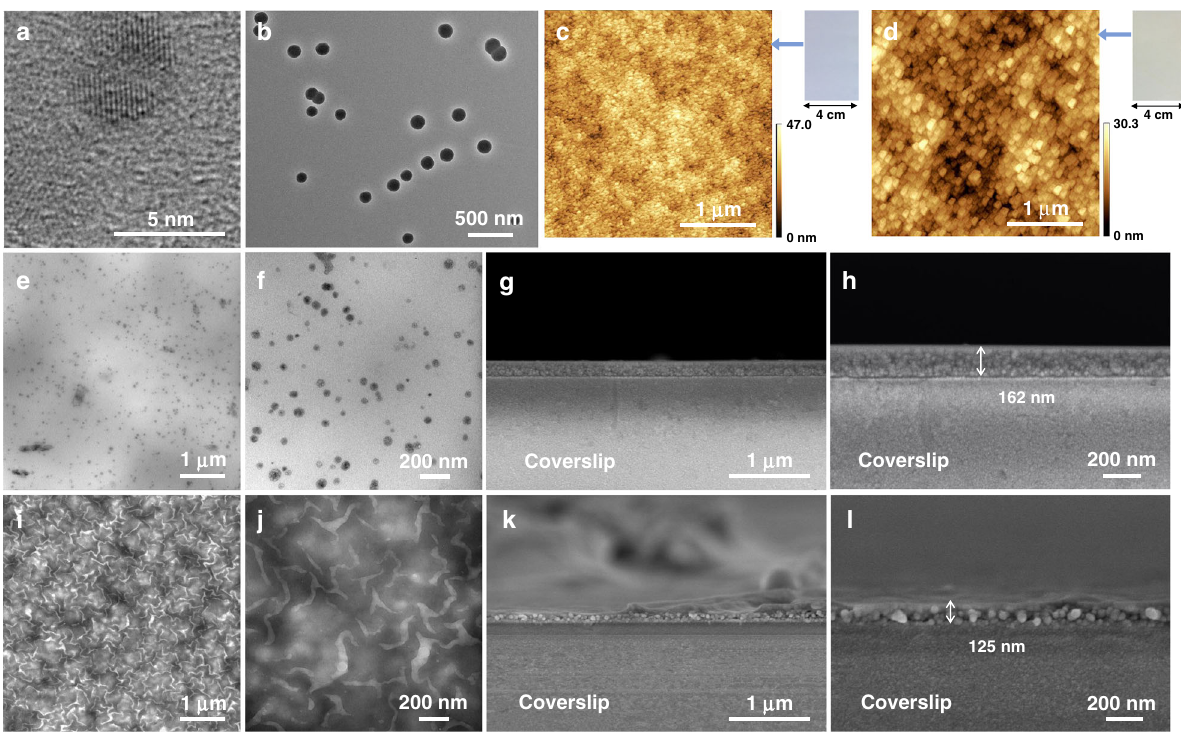
Fig. 2 Morphology characterizations. a TEM image of the single polyamide G4 dendrimer (G4D). b TEM image of the G4D nanoparticles formed by diazotization-coupling reaction. c AFM image of the pristine PSF support. d AFM image of the polyamide dendrimer porous layer. e , f TEM images of the traditional polyamide nano fi lm without dendrimer porous layer. g , h SEM cross-sectional images of the traditional polyamide nano fi lm supported by coverslips. i , j TEM images of the asymmetric polyamide nano fi lm. k , l SEM cross-sectional images of the asymmetric polyamide nano fi lm supported by